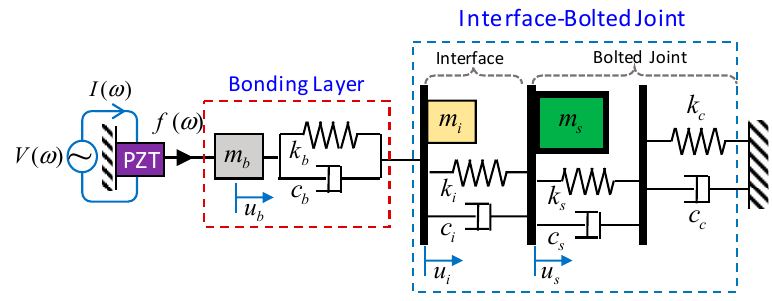
Figure 9. Refined impedance model of the PZT interface-bolted joint system.